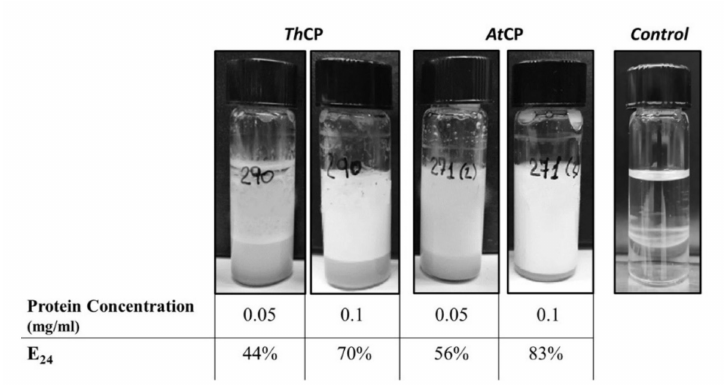
Figure 2. Dectol emulsions at two di ff erent protein concentrations. Th CP and At CP solutions were mixed with Dectol (2:1 v / v ) and analyzed after 24 h. Dectol emulsion with 10 mM Phosphate bu ff er, pH 7, is reported as control.